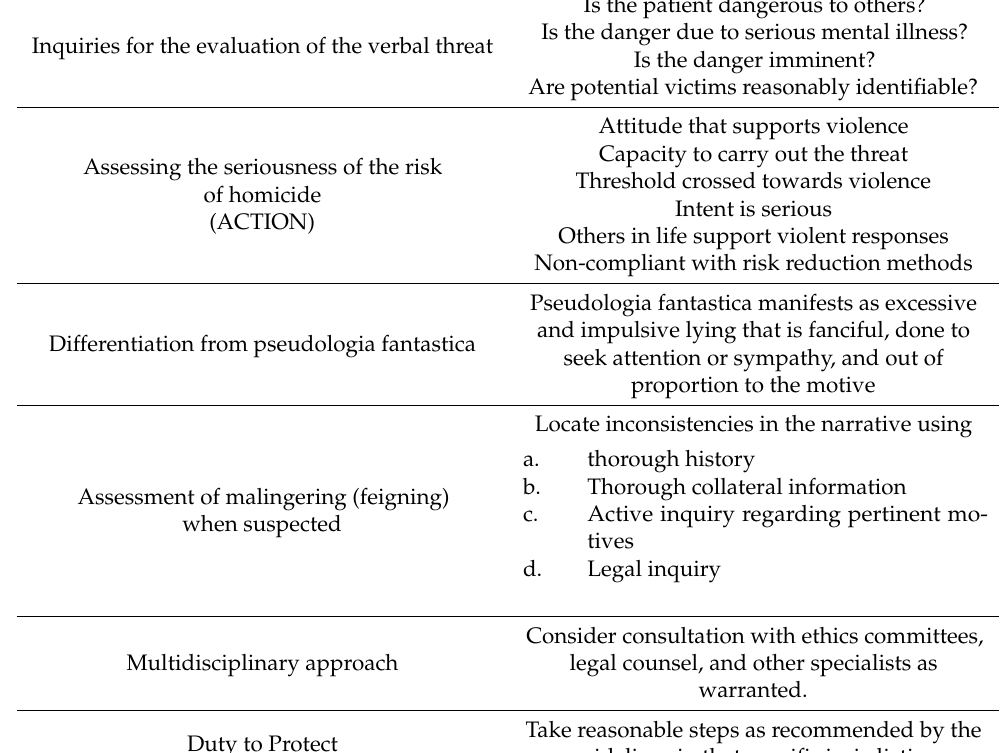
Table 2. Steps recommended towards the evaluation and management of feigned